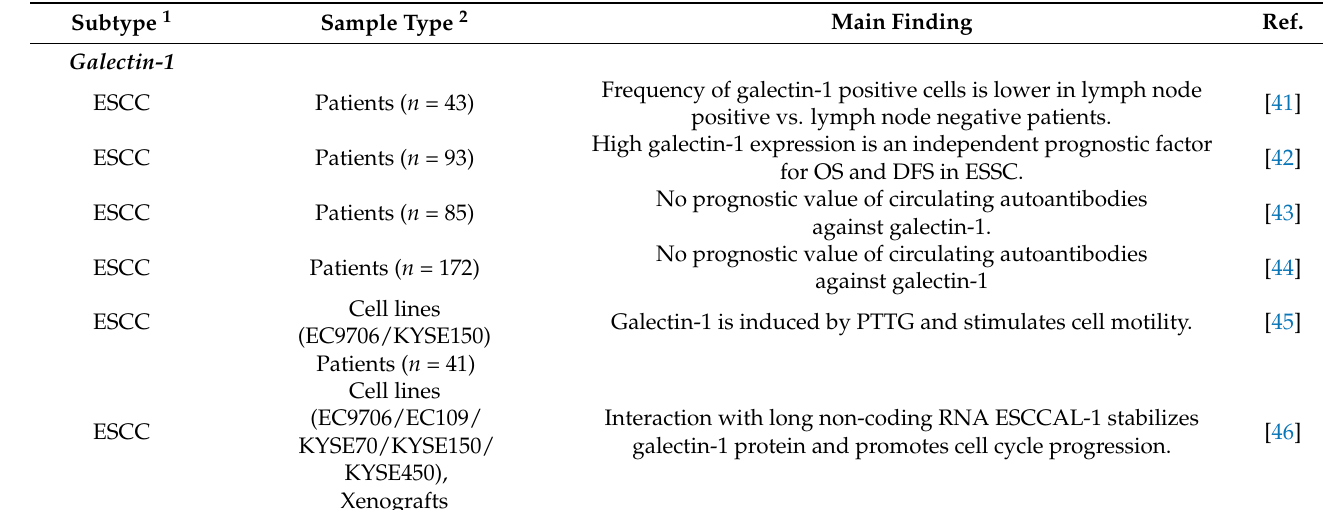
Table 1. Galectins in esophageal